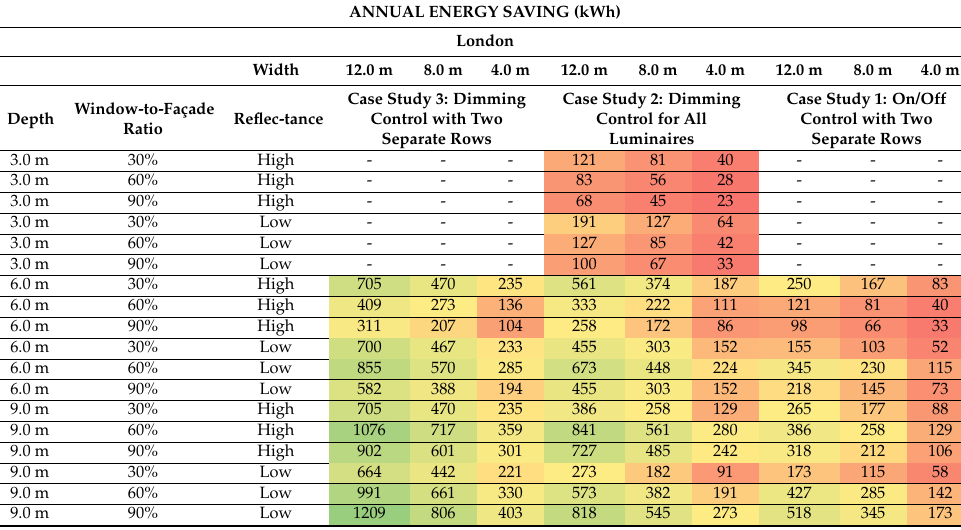
Table 9. Annual energy saving in kWh of different lighting smart controls in